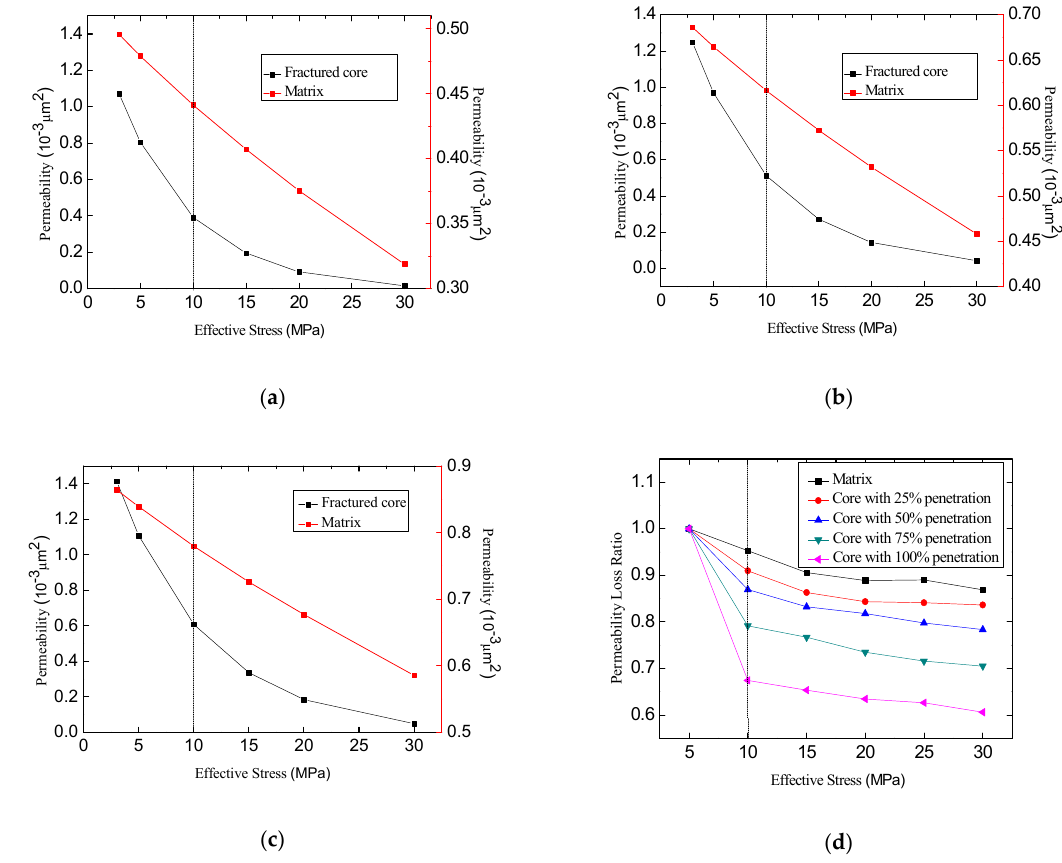
Figure 6. The experimental results of stress-dependent permeability of cores in ( a ) set 1, ( b ) set 2, and ( c ) set 3, and ( d ) fractured cores with different penetration extents.